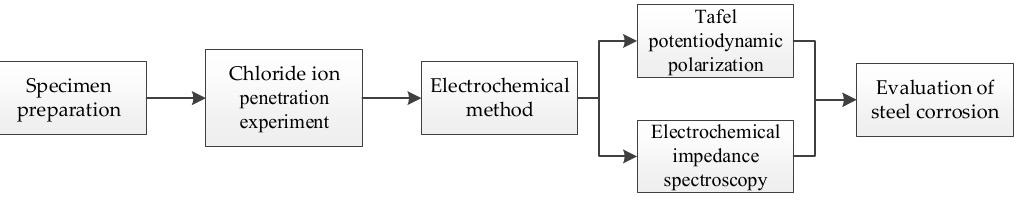
Figure 5. Experimental procedure.